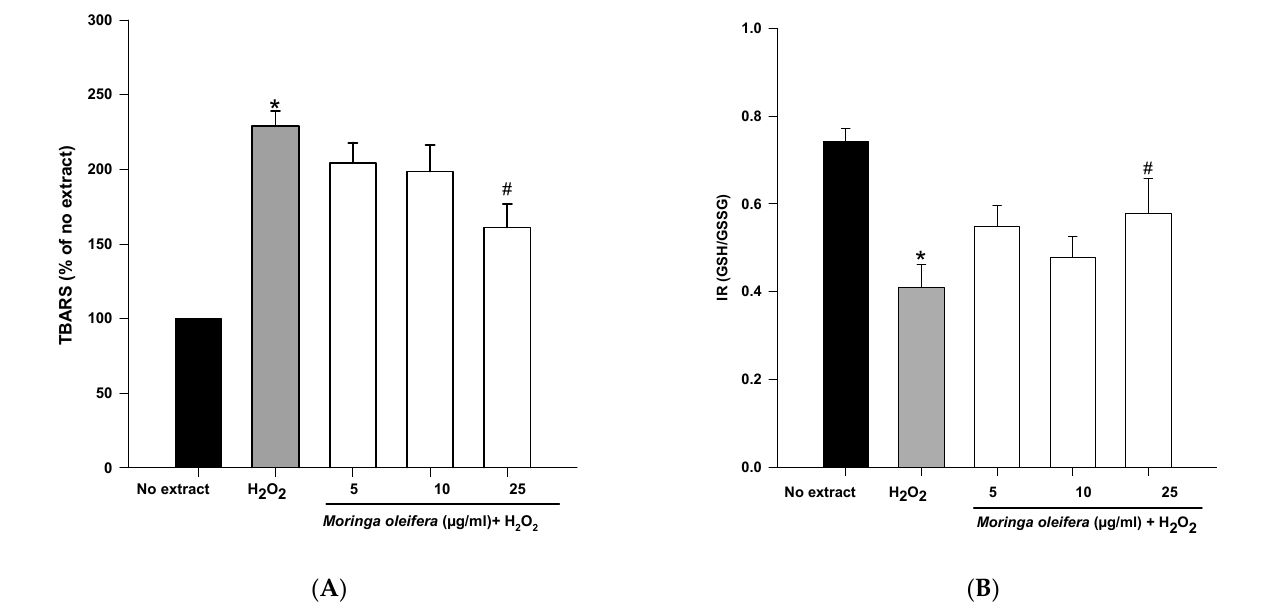
Figure 3. Effect of methanol extracts of Moringa oleifera leaf powder on ( A ) lipid peroxidation and ( B ) Index Redox (GSH/GSSG). Cells were pretreated with moringa (5, 10 and 25 µg/ml) for 24 h before 100 µM H 2 O 2 for 1 h. * p < 0.05 versus no extract, # p < 0.05 versus H 2 O 2.